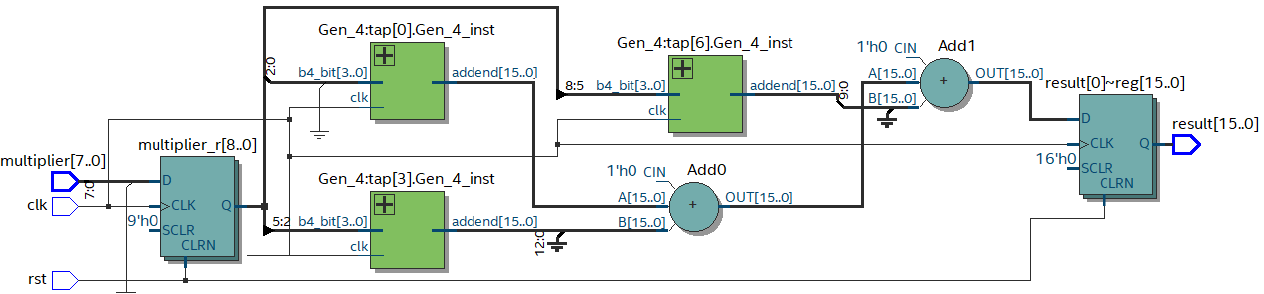
Figure 10. RTL of the 8-bit hardware implementation of the proposed algorithm that realizes multiplication by a constant.